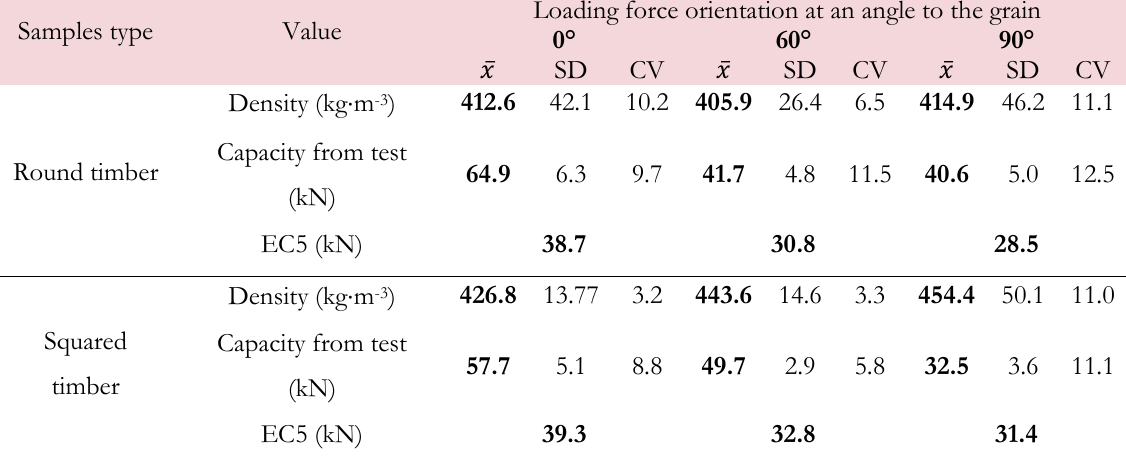
Table 2: Summary of the carrying capacity test results and the calculated values of load carrying capacity according to EC5 ( x is the arithmetical average; SD is the standard deviation; CV is the coefficient of variation).